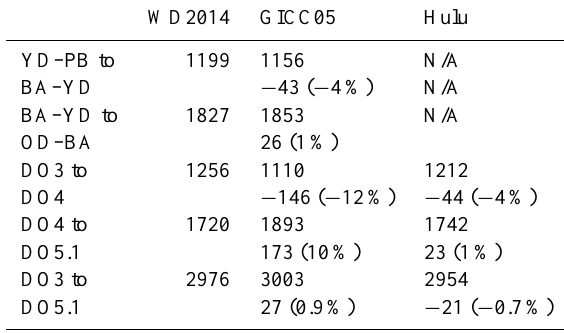
Table 5. Comparison of interval durations between WD2014, GICC05 (NGRIP-Project-Members, 2004) and Hulu Cave (Ed- wards et al., 2016) chronologies. Years of difference are given as reference – WD2014. We use a Greenland-CH 4 phasing of 50 ± 30 years for the Younger Dryas (YD) to Preboreal (PB) transition, 45 ± 30 years for the Older Dryas (OD) to Bølling–Allerød (BA) transition and 25 ± 30 years for all other transitions (Rosen et al., 2014; Buizert et al., 2015). We assume no age difference between Hulu and CH 4 during the transition of DO 5.1, DO 4 and DO